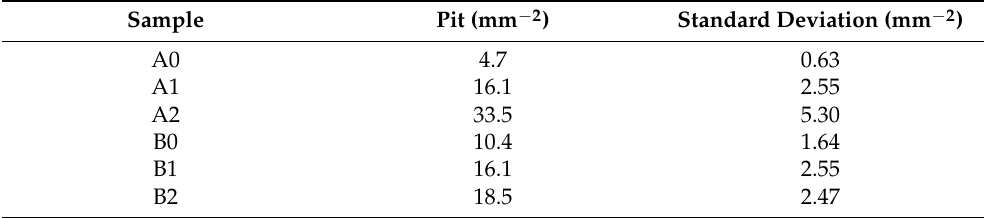
Table 7. Mean values and standard deviations of the pit density of the samples submitted to the corrosion